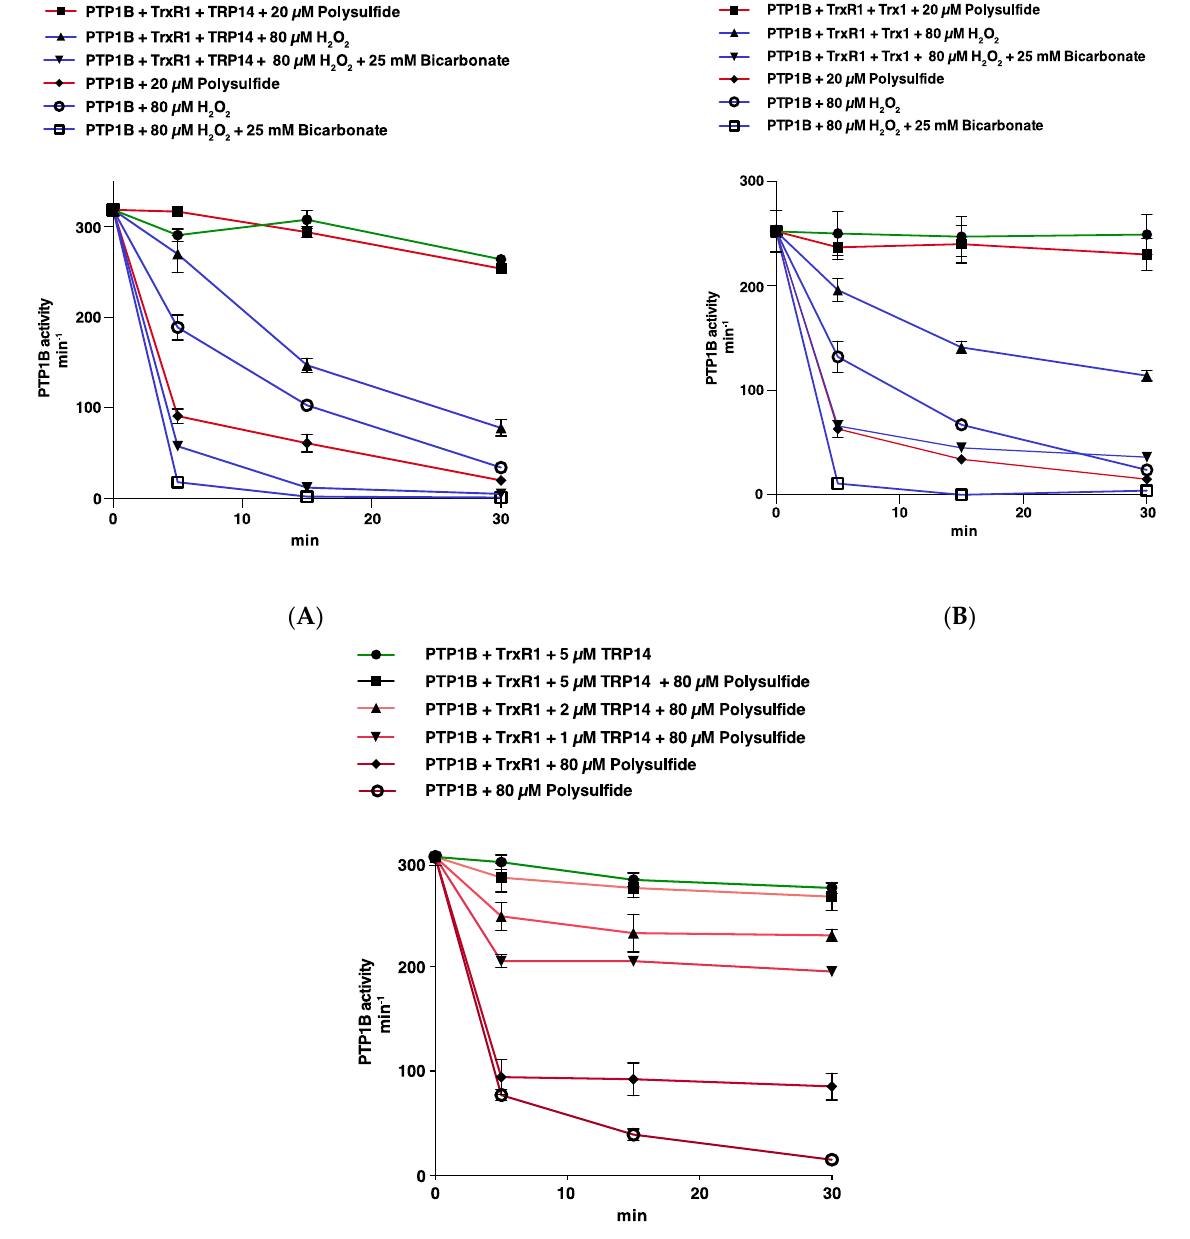
Figure 2. The reductive thioredoxin 1 (Trx1) or Trx-related protein of 14 kDa (TRP14) systems can prevent inactivation of PTP1B by polysulfides but not by the combination of HCO 3 − and H 2 O 2 . ( A ): PTP1B (600 nM) was treated with 80 μ M H 2 O 2 (blue curves) or 20 μ M polysulfide (red curves), with and without addition of 25 mM HCO 3 − and the presence of TRP14 (10 μ M), NADPH (300 μ M), and TrxR1 (250 nM), as indicated. PTP activity was determined after 5, 15, and 30 min of incubation and data points represent means ± SEM ( n = 3). ( B ): PTP1B was treated as in panel A but using 10 μ M Trx1 instead of TRP14. ( C ): Treatment of PTP1B with polysulfide was performed as in panel A but in the presence of varying concentrations of TRP14 as indicated in the figure.